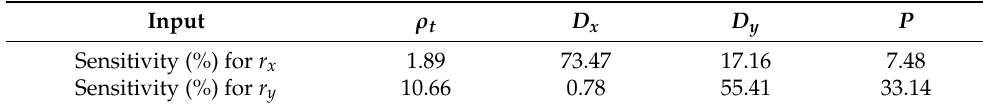
Table 3. Sensitivity analysis of the input parameters in the gene expression programming (GEP) model.